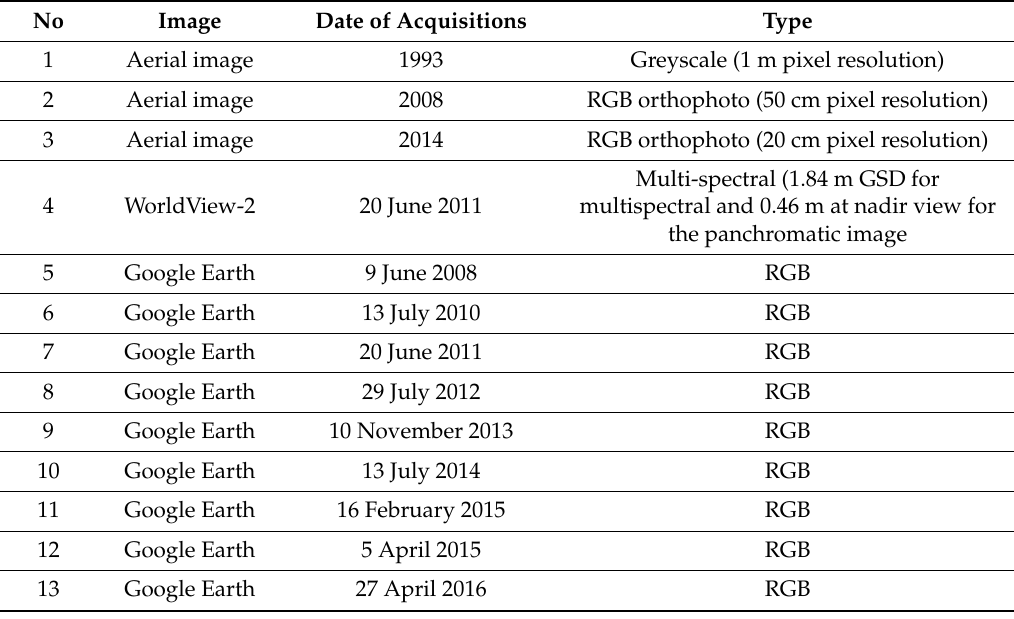
Table 1. Datasets used for the current study. GSD: ground sampling distance; RGB: red-green-blue. No